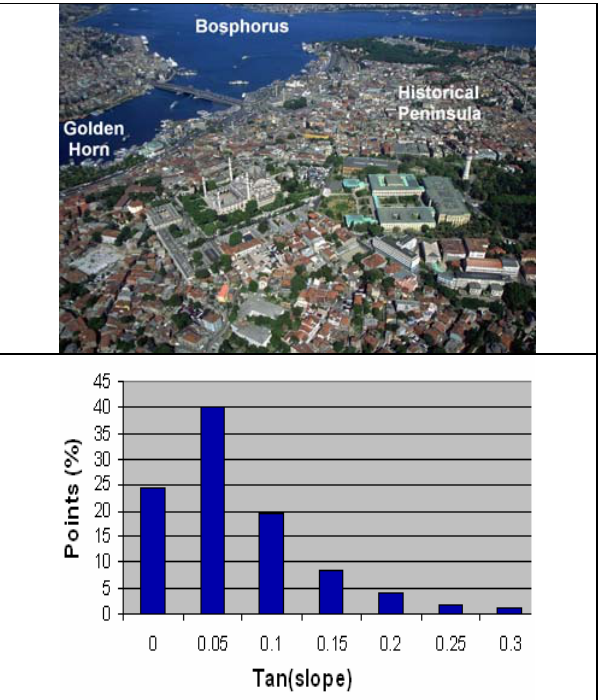
Figure 1. Test field and frequency distribution of terrain inclination